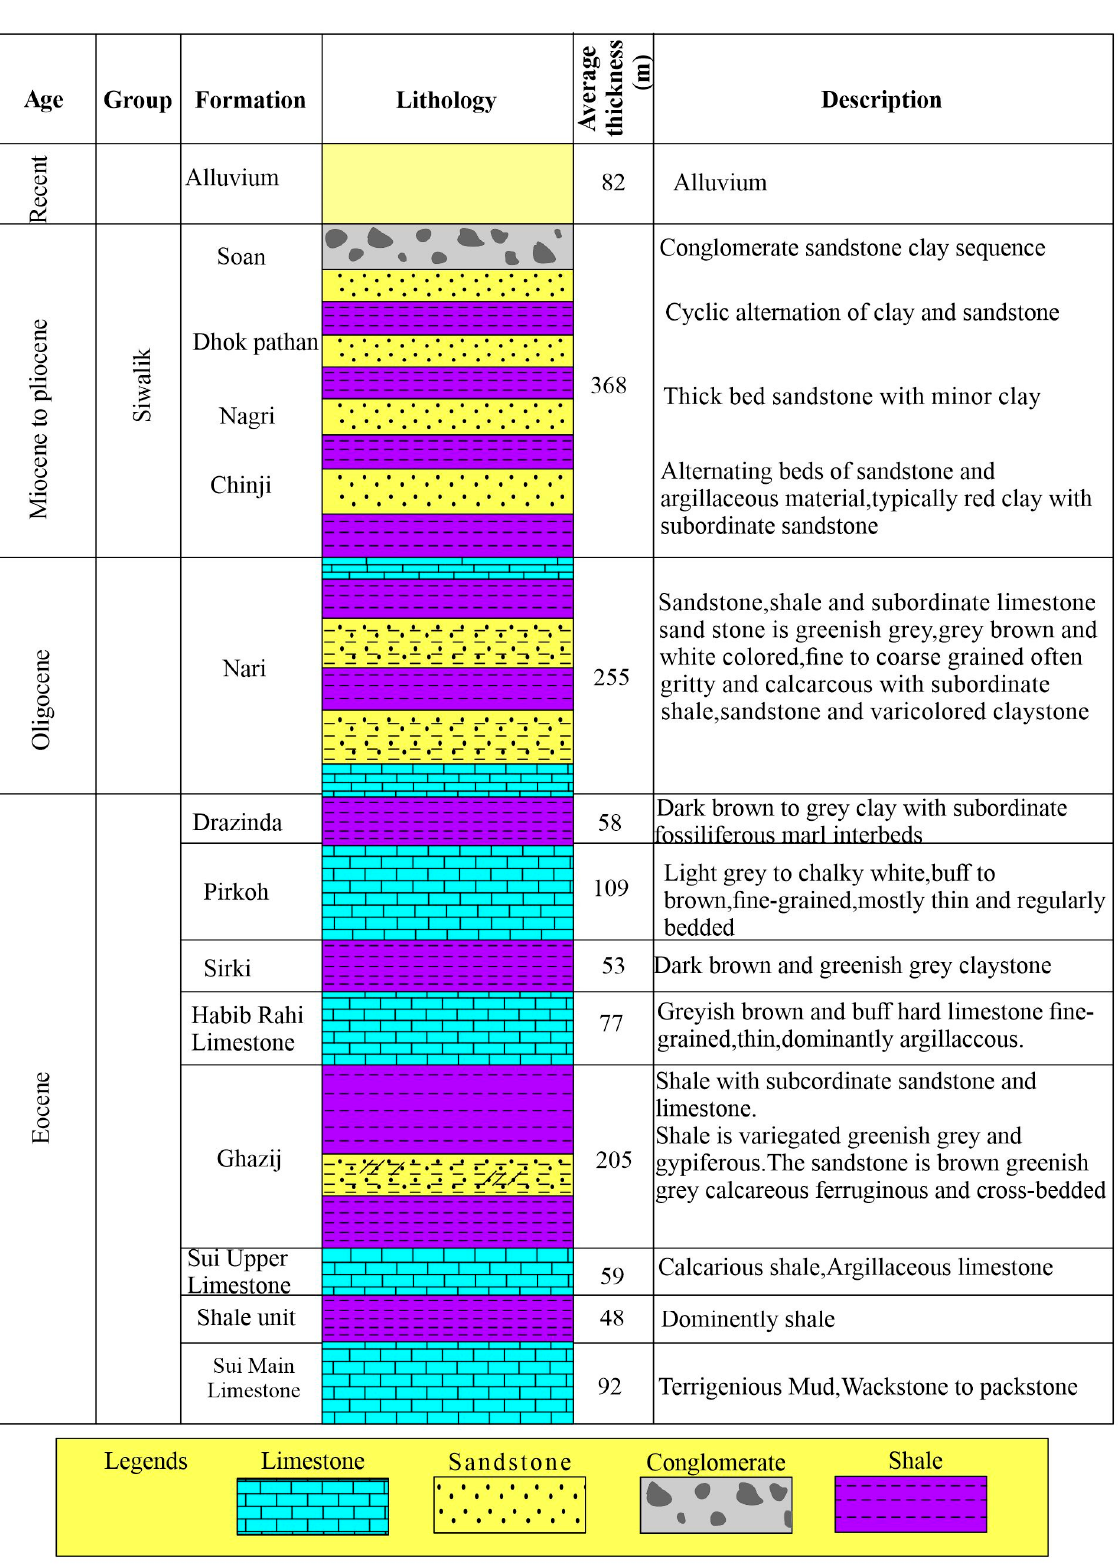
Figure 2. Stratigraphic chart of the QGF.